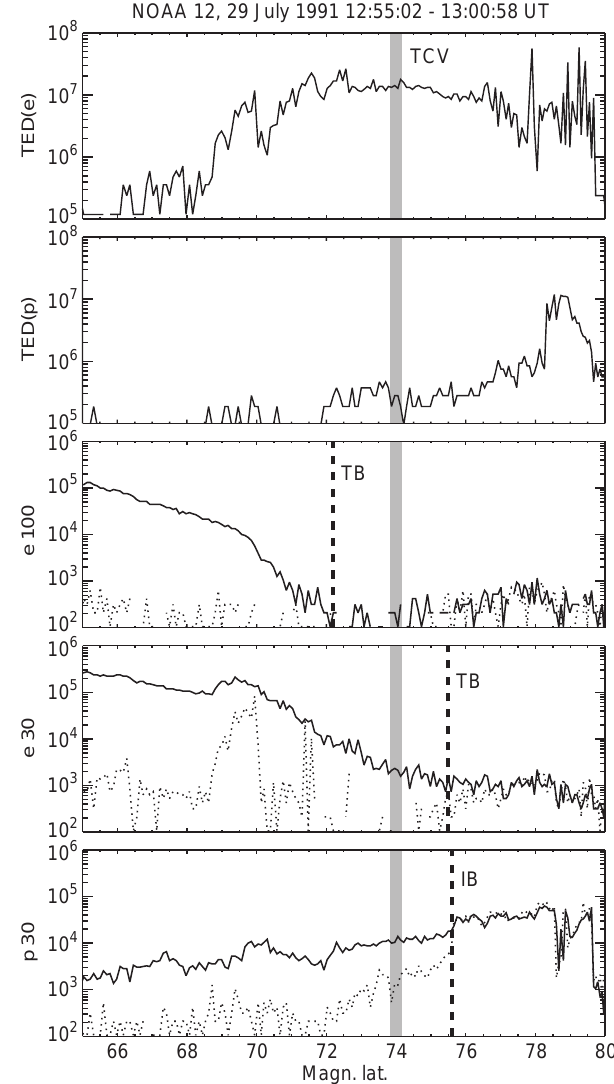
Magn. lat. 9.0 MLT. The legend for the MEPED data of the bottom three panels is as for Fig. 2. The top two panels in each column display the directional particle flux of the TED instrument for the low energy electrons and protons, respectively, in units of 1 = cm 2 s